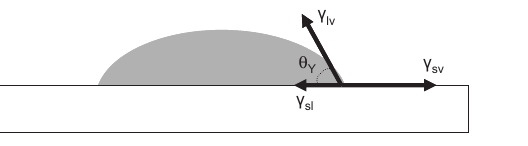
Figure 1 Definition of the Young contact angle ( θ